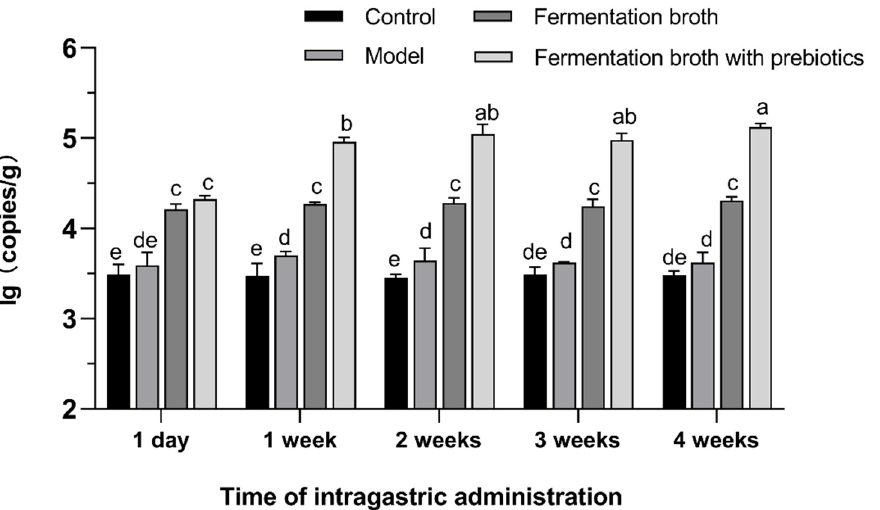
Figure 2. Effect of intervention time on colonization quantity of L. fermentum DALI02. a, b, c, d, e indicates a significant difference between groups ( p < 0.05).